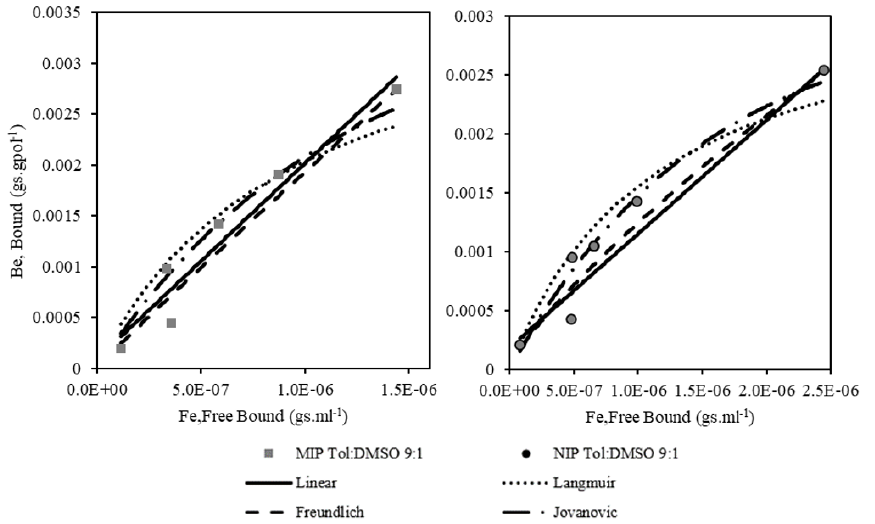
Figure 6. Fitting the experimental data at equilibrium with Linear, Langmuir, Freundlich, and Jovanovic adsorption models.